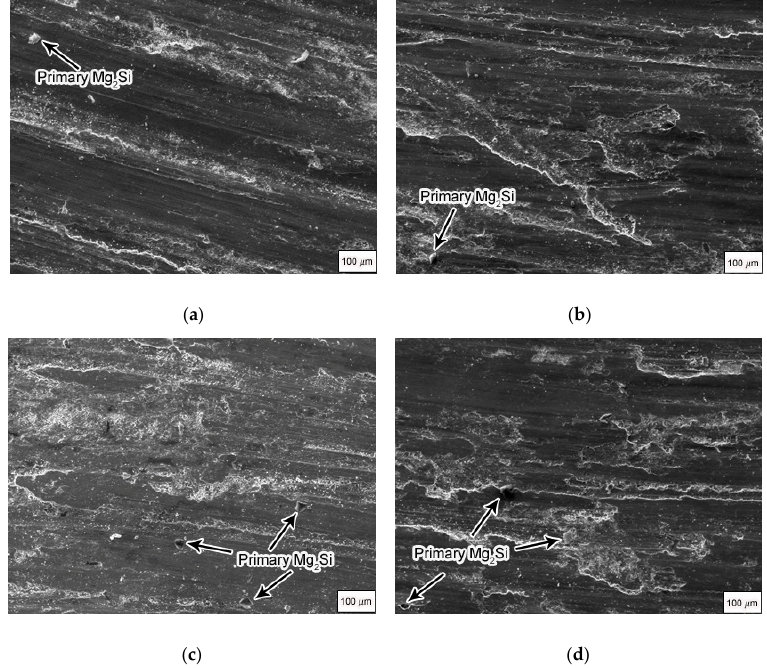
Figure 8. SEM of wear surfaces of Mg 2 Si–Al composites fabricated by using ( a ) gravity casting and semi-solid extrusion with isothermal heat treatment holding times of ( b ) 50 min, ( c ) 60 min, and ( d ) 160 min with a sliding velocity of 1000 r/min.